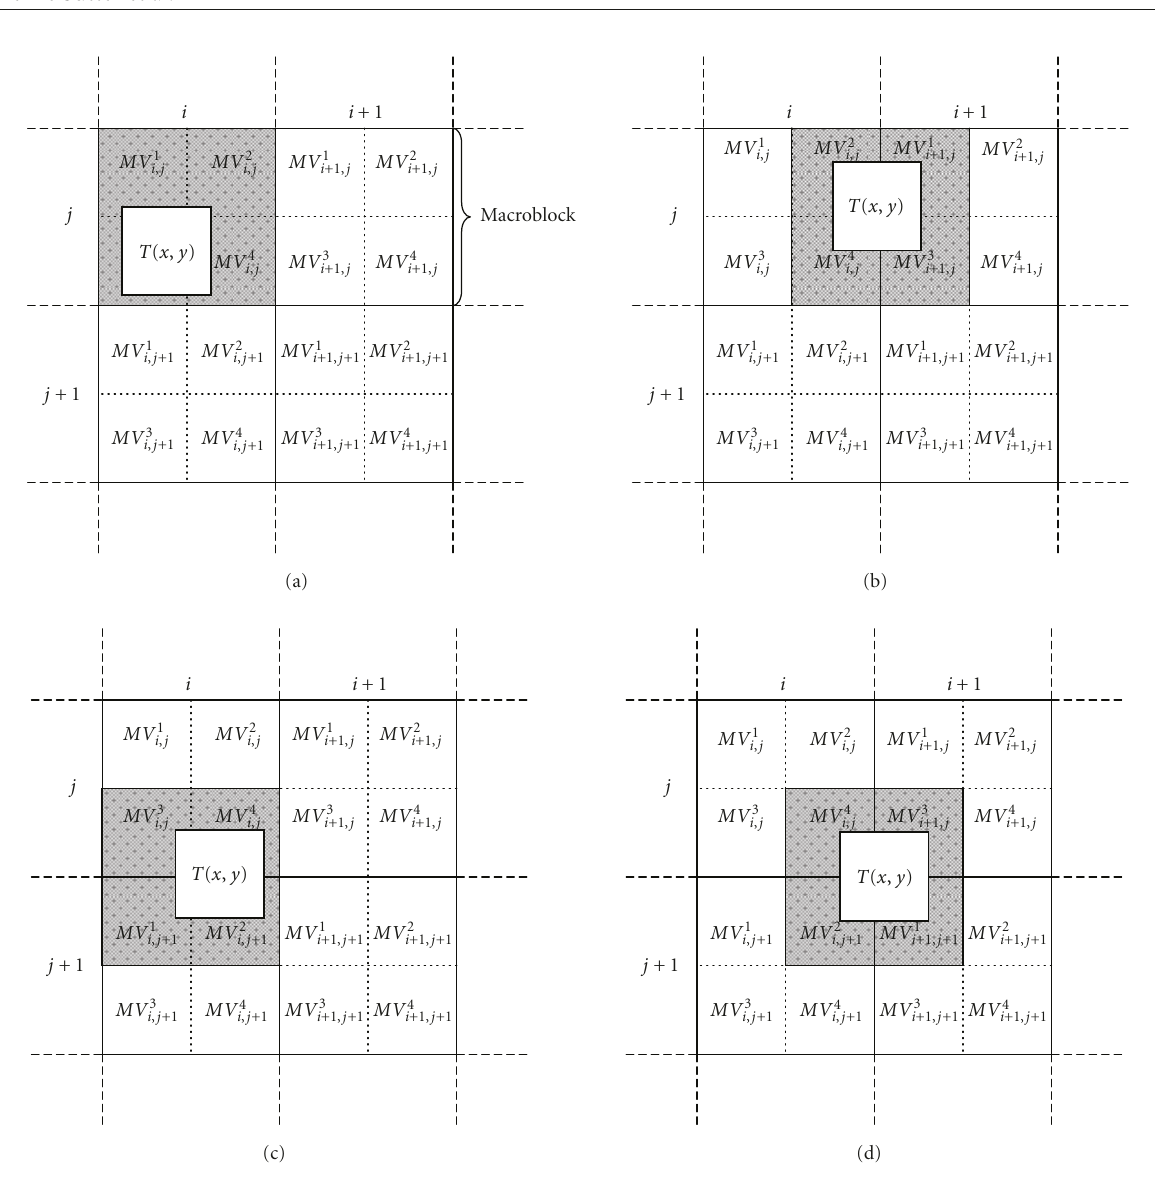
Figure 5: Selecting the four appropriate motion vectors for ROI mask element T ( x , y ), based on the overlap with the